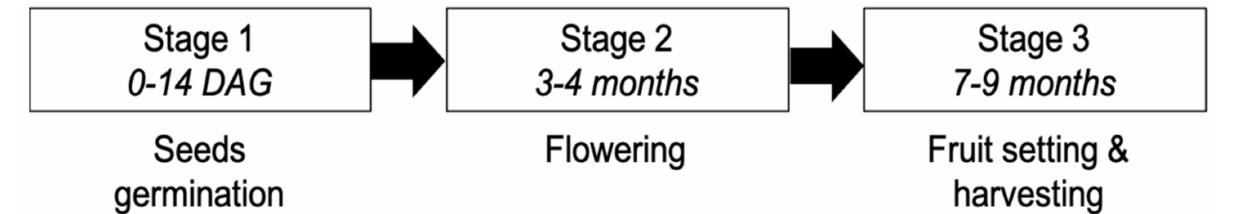
Figure 1. The breeding cycle of papaya. DAG denotes day after